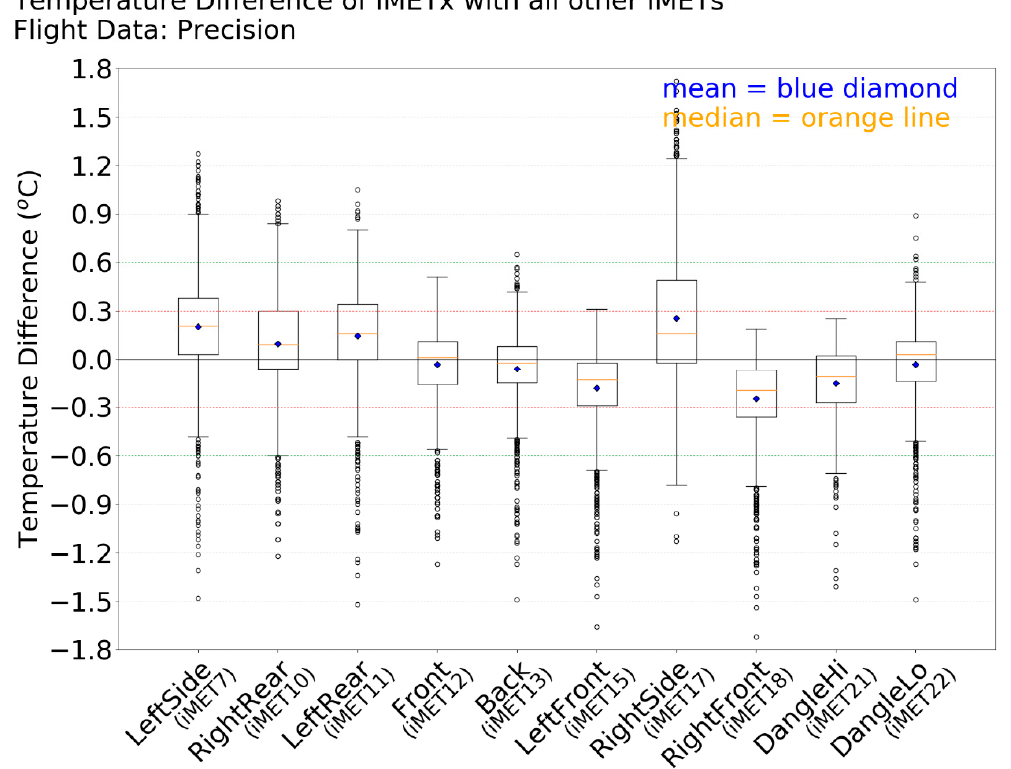
Figure 6. Temperature difference (°C) boxplots for each iMET-XQ sensor and all other iMET-XQ sensors for all flight experiments. The means are represented by blue diamonds, and the medians are shown by orange lines. A temperature difference of 0.3 °C is marked by a red dotted line. A temperature difference of 0.6 °C is marked by a green dotted line.